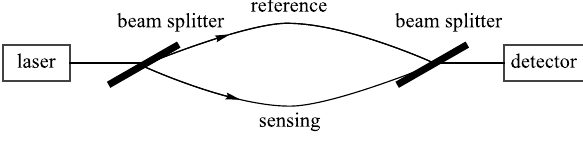
Fig. 7 Schematic representation of an Fabry−Perot interferometer